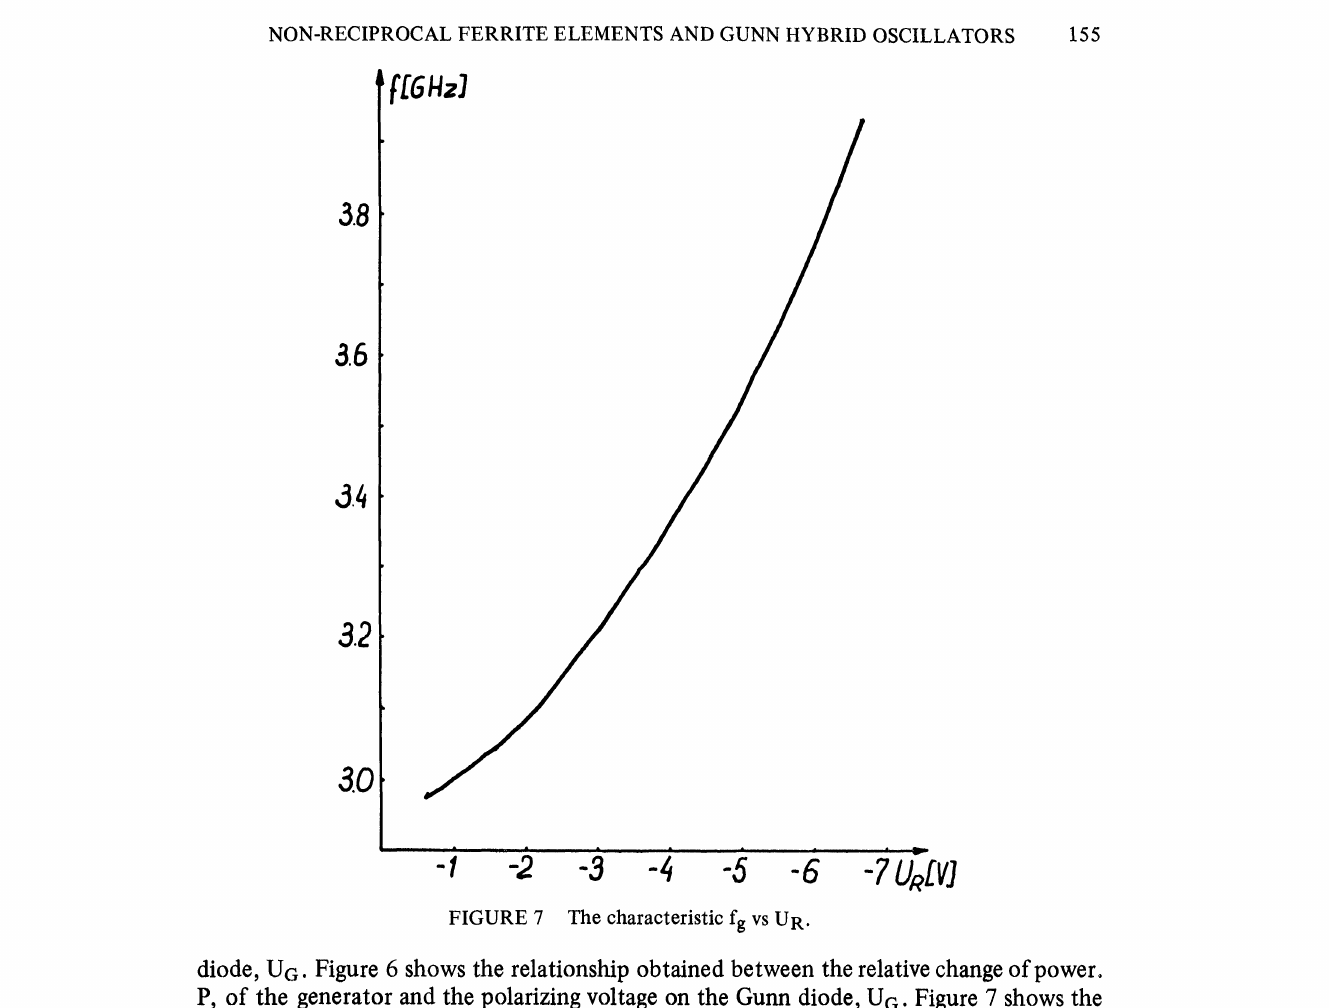
FIGURE 7 The characteristic fg vs